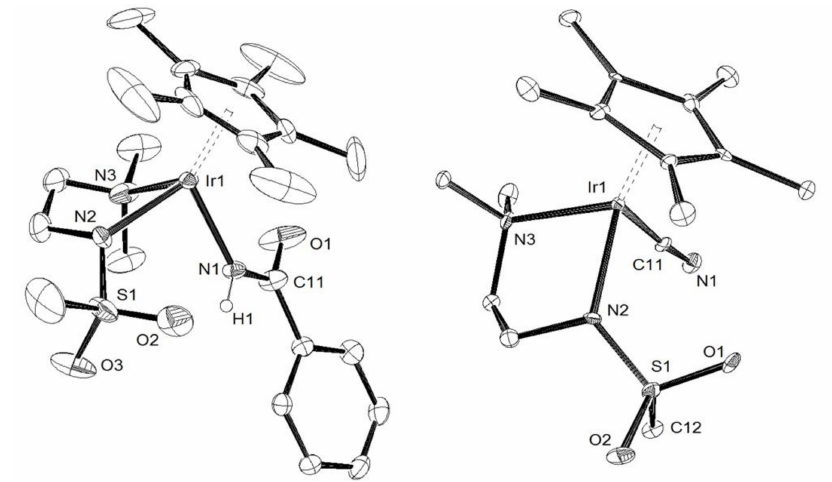
Figure 2. ORTEP drawings of 3 (left) and 6 (right). Hydrogen atoms are omitted for clarity, and the ellipsoids represent 30%